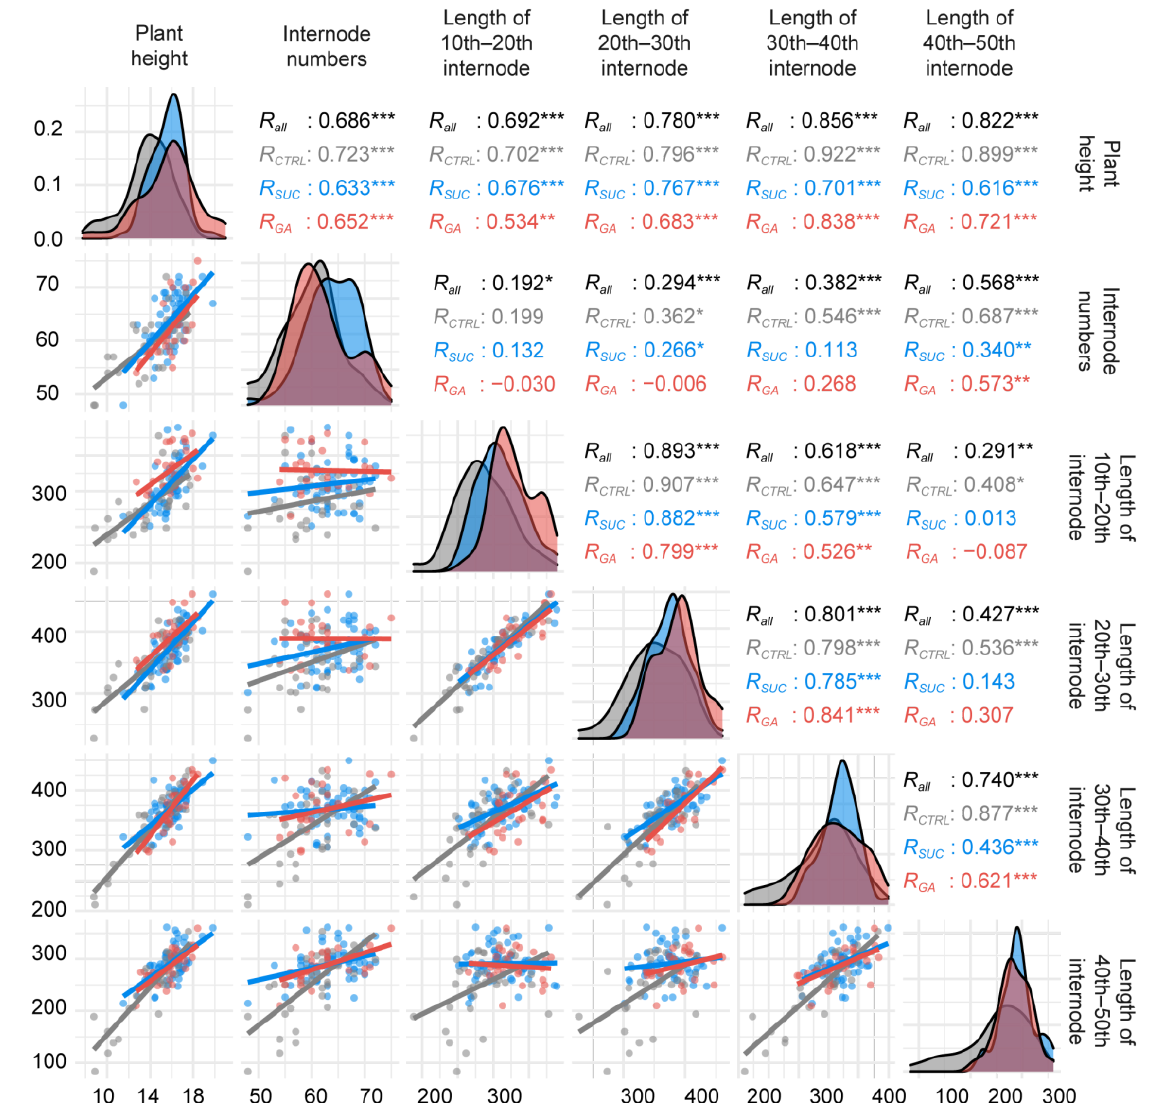
Figure 2. Correlations between the plant height; internode numbers; and lengths of the 10th–20th internodes, 20th–30th internodes, 30th–40th internodes, and 40th–50th internodes under different exogenous treatments. The different colors show each exogenous treatment. Numbers indicate Pearson correlation coefficients (* p < 0.05, ** p < 0.01, *** p < 0.001). Multidensity plots and scatterplots show the distributions of the variables.